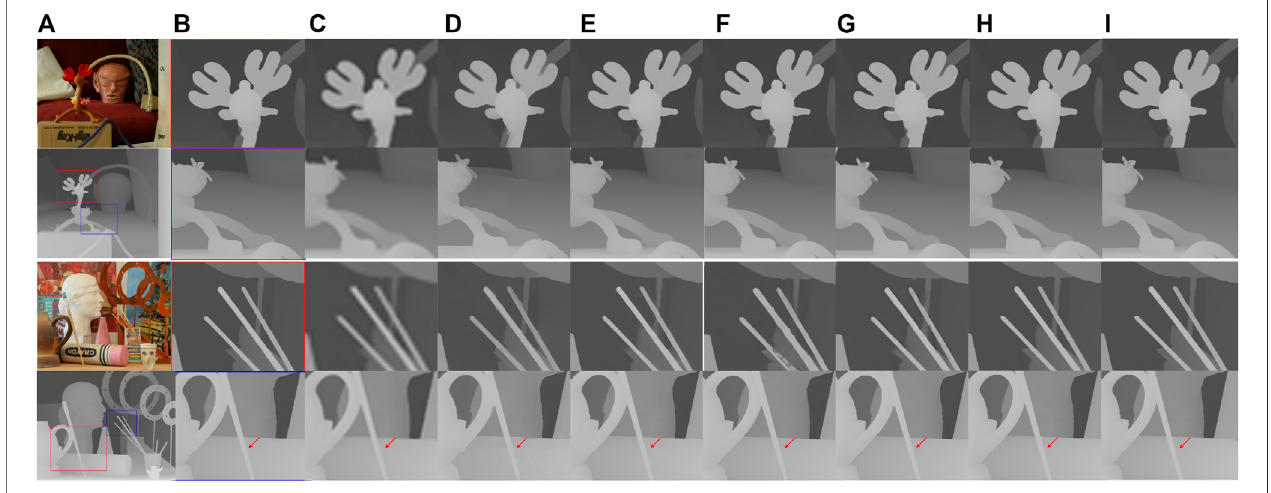
FIGURE3| Avisualquality comparison fordepthmapSRatascalefactor of8onthenoise-free “ art ” and “ Reindeer ” datasets. (A) HRcolorand depthimages, (B) extracted ground truth patches, and upsampled patches by (C) Bicubic, (D) RDGE (Liu et al., 2016), (E) MSG (Hui et al., 2016), (F) DSR (Guo et al., 2018) (G) RDN (Zuo et al., 2019a) (H) PMBA (Ye et al., 2020) (I) our proposed method (best viewed on the enlarged electronic version).